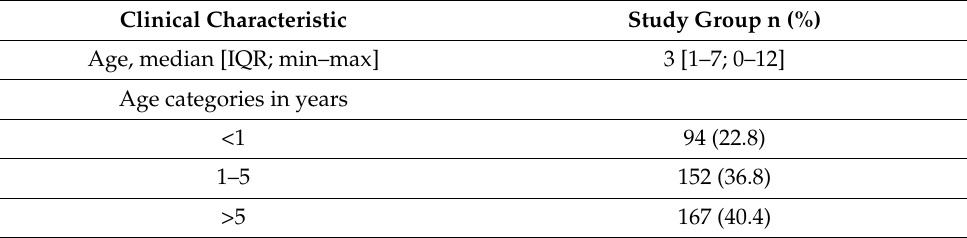
Table 1. Demographics and clinical characteristics of the enrolled